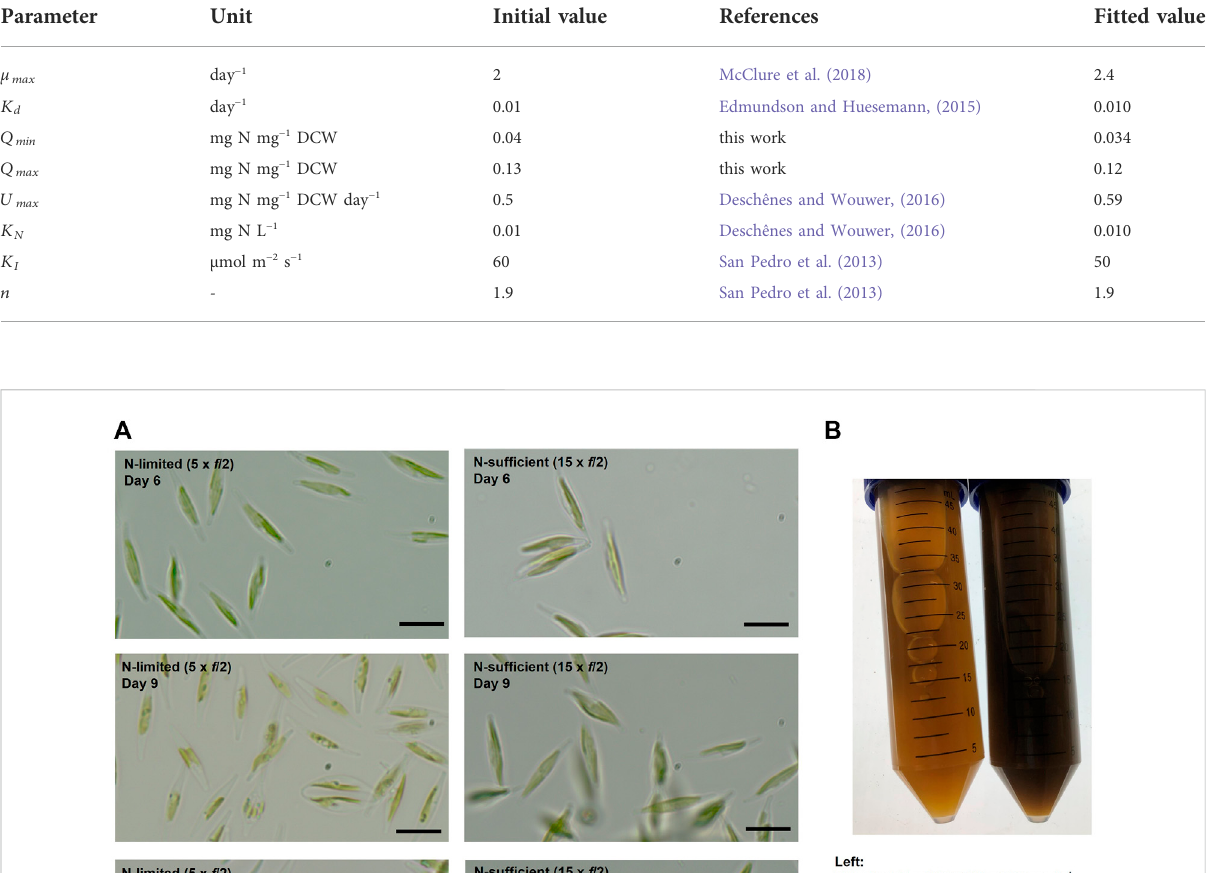
TABLE 1 Initial and fi tted values of parameters for the growth and nitrogen uptake model.